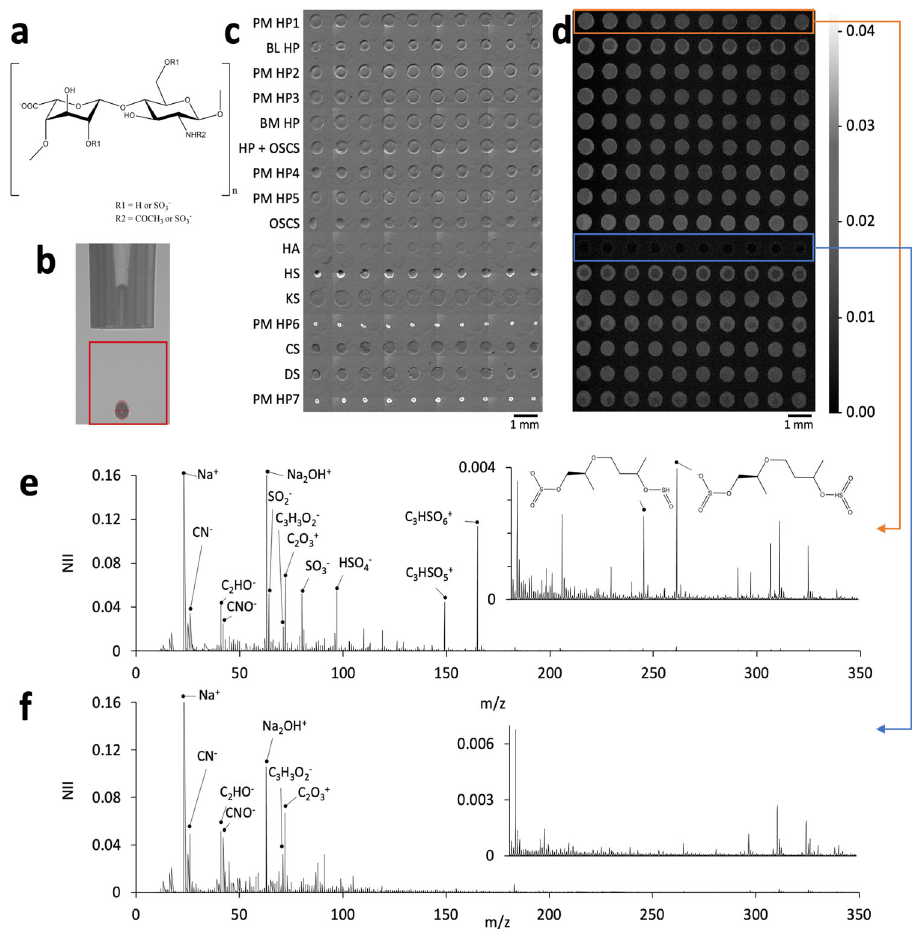
Fig. 1 Preparation and analysis of a GAG microarray. GAGs were derived from porcine mucosa (PM), bovine mucosa (BM) or bovine lung (BL). If unspeci fi ed, samples are derived from PM. a Chemical structure of the main disaccharide of heparin, in which R1 and R2 are usually SO 3 − . b Side view image of piezo-dispensing glass nozzle used to dispense GAG solutions to prepare an array. Droplet detection highlighted within the marked region of interest. Typical droplet volume was 320 – 340 pL. c Bright fi eld microscopy image of prepared array (where print order was sequential from top to bottom) and d a corresponding SO 4 − ion image acquired using ToF-SIMS. Intensity scale indicates the measured normalised ion count depicted in d . All spots remained distinct and no SO 2 − signal was observed from HA. Region of interest selection for extracting the spectrum from each spot was based upon the high intensity region from the SO 2 − signal, or low intensity area for HA. e – f Extracted ToF-SIMS spectra for e porcine mucosa derived heparin f